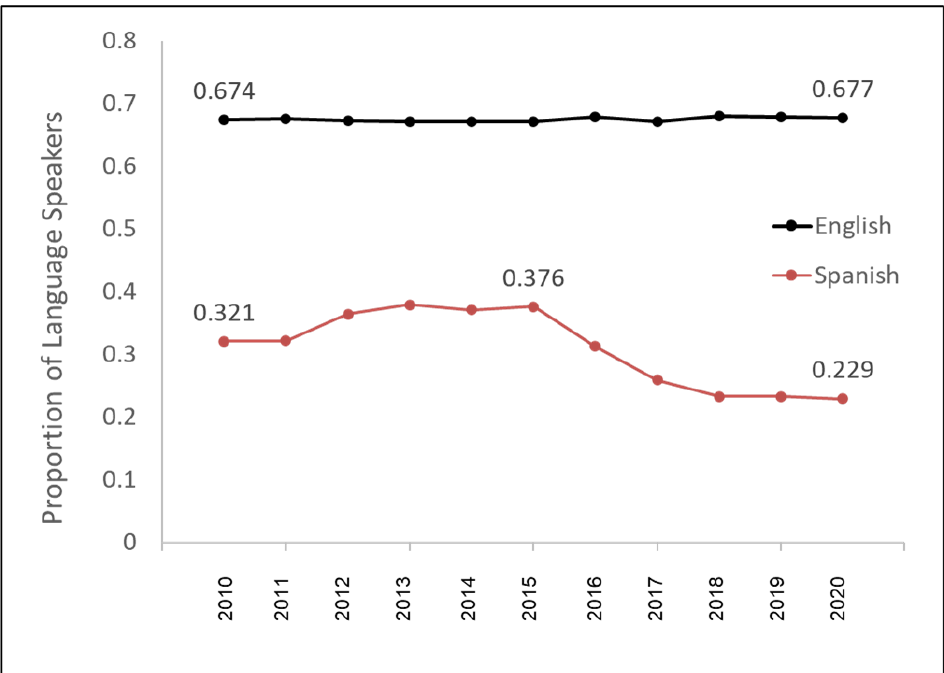
Figure 2. Change in proportion of racial and ethnic minorities within the patient population over time. The proportion of White/Caucasians remained fairly constant over time (16.8%, 2010 and 24.6%, 2018) although Hispanics decreased from 67.9% (2011) to 35.7% (2020). In contrast, the proportion of Black patients increased over time from 8.9% (2010) to 18.2% (2020), similar to the trend observed with Asians (2.6%, 2010 to 5.5%, 2020).